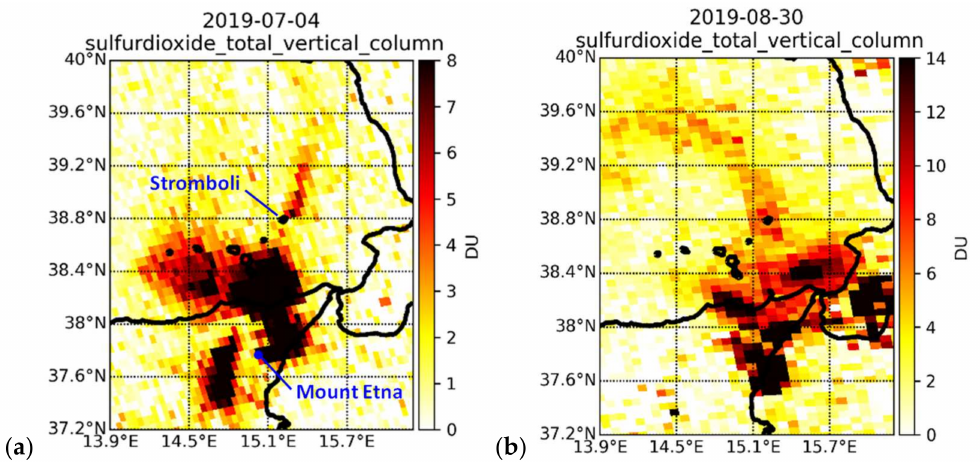
Figure 6. TROPOMI SO 2 column density observations over the Aeolian archipelago and north- eastern Sicily on ( a ) 4 July 2019 at ~12:00 UTC and ( b ) 30 August 2019 at ~12:35 UTC, showing clearly distinguishable plumes of Mount Etna and Stromboli in the former, and plume overlapping by clustered degassing in the